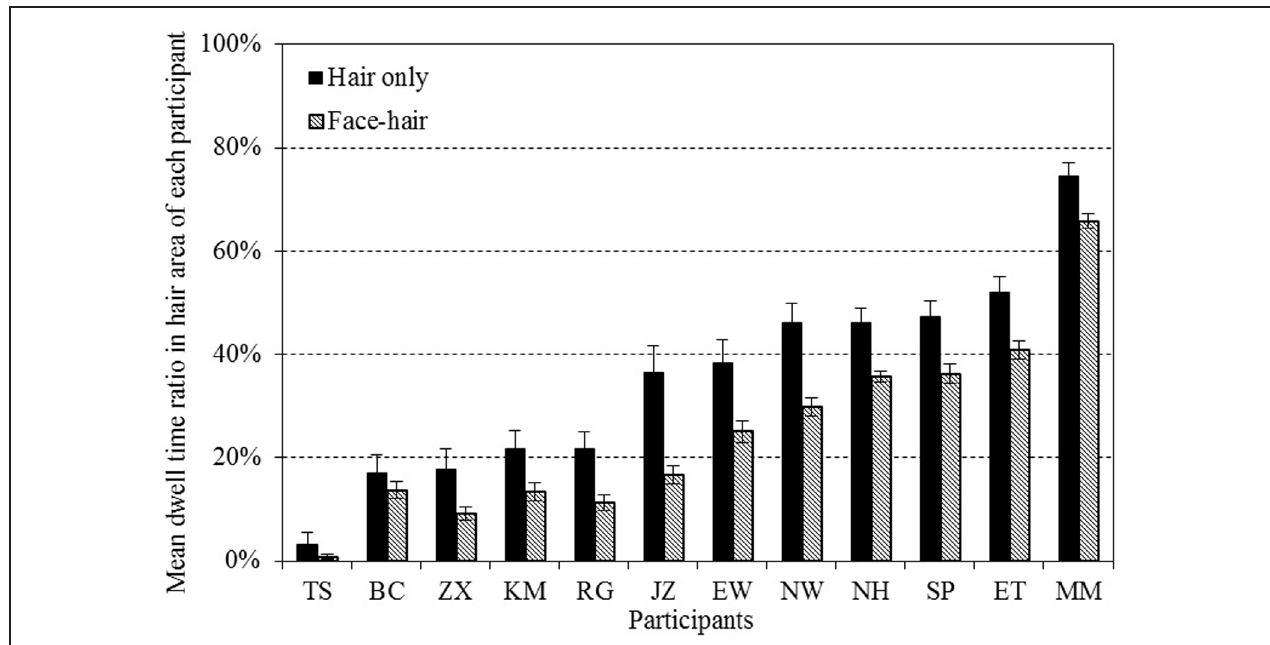
FIGURE 5 | The dwell time ratio of eye gaze within the hair area (DwR H ) of each participant in the hair attractiveness evaluation task. Although the ratio varied across participants, the DwR H in the trials with face–hair composites was lower than the trials with hair-only composites in all of them. Error bars in the graph represent ± 1